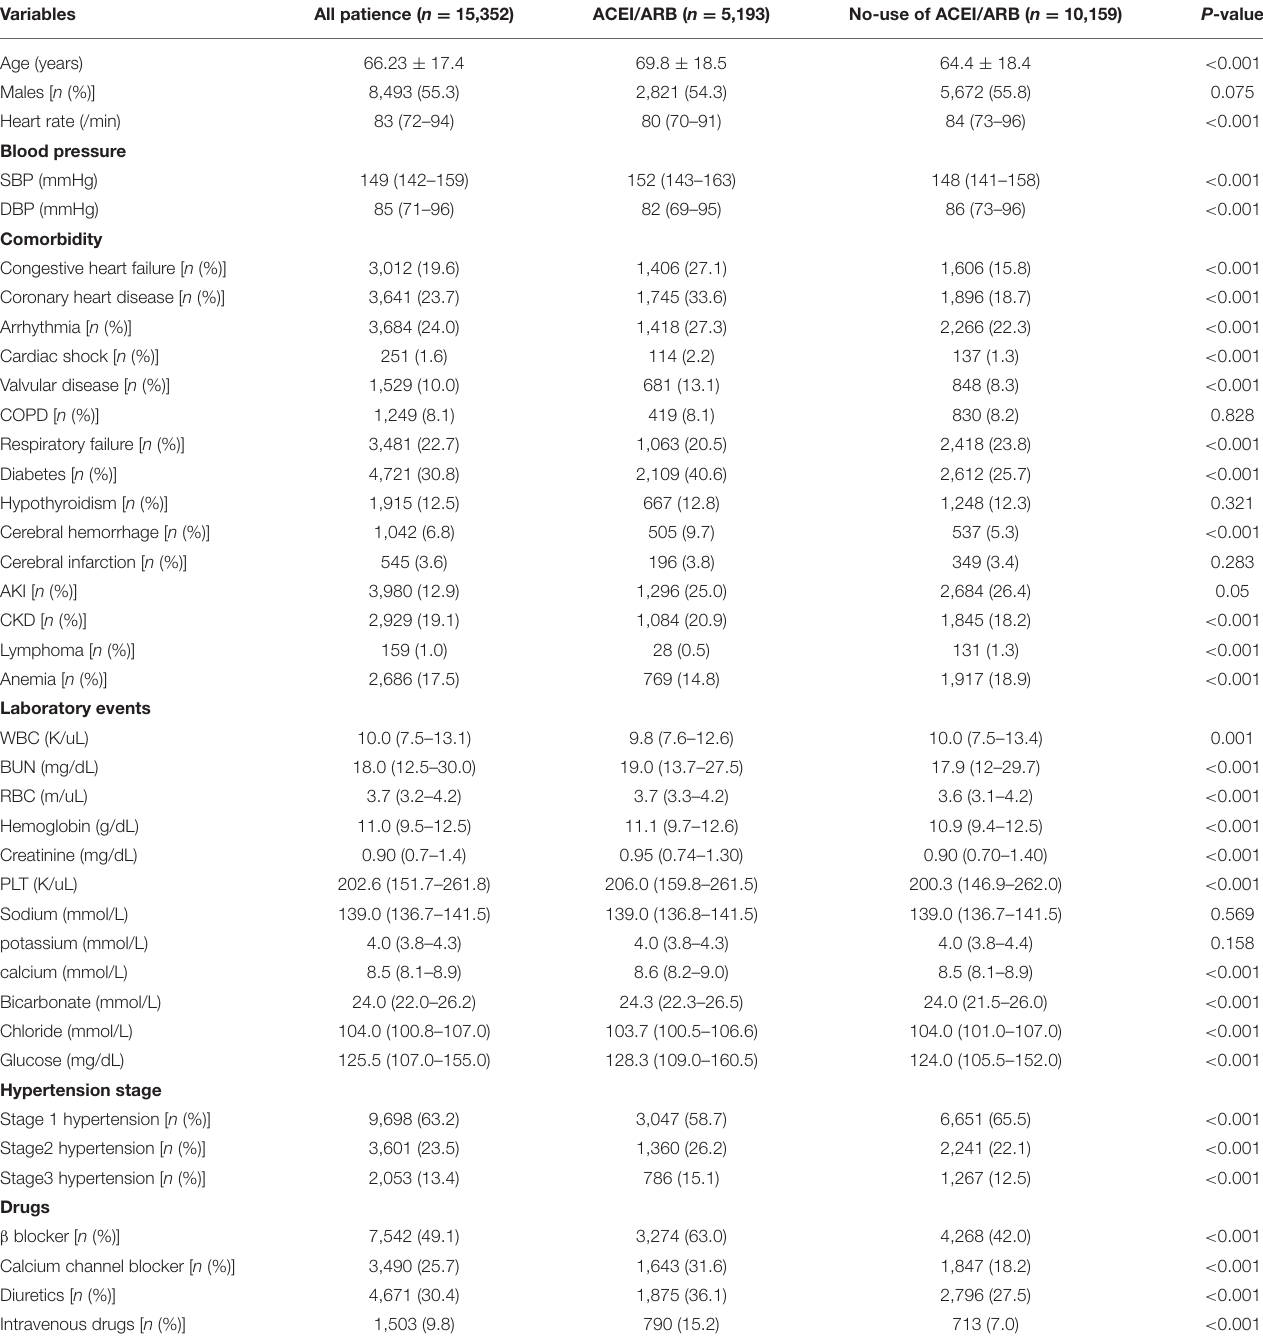
TABLE 1 | Comparison of baseline characteristics between patients treated with ACEI/ARB and those treated without ACEI/ARB.